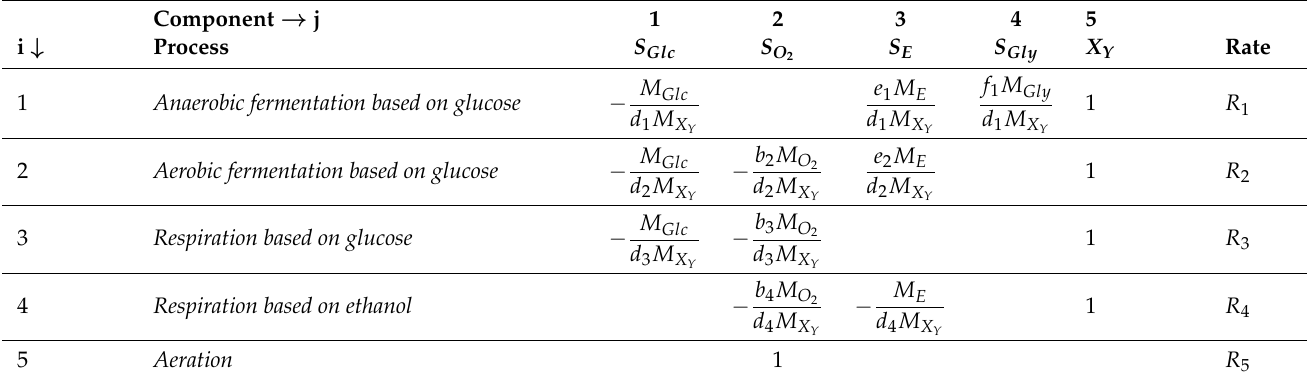
Table 1. Matrix representation of the biological model.